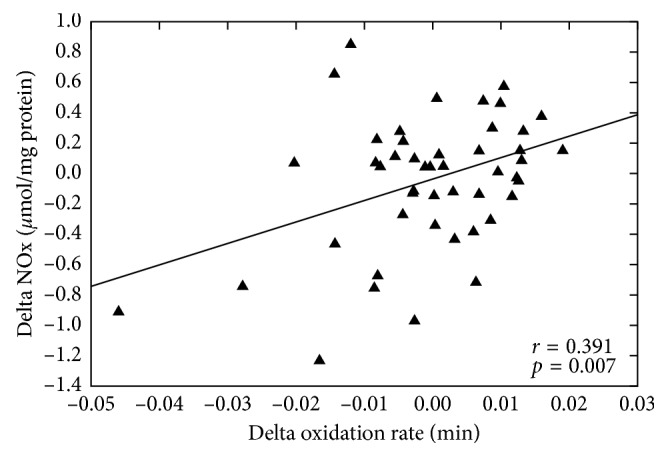
Relationship between serum NOx levels and the oxidation rate of the lipid moiety of LDL particles ex vivo. NOx: nitric oxide metabolites (nitrite and nitrate); LDL: low-density lipoprotein.